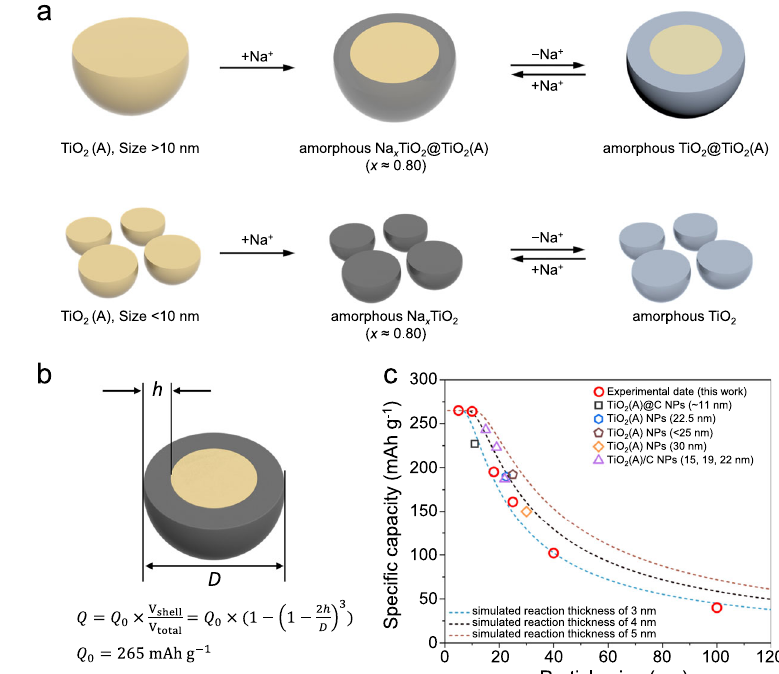
Fig. 3 | Overview of the sodium-ion storage mechanism of TiO 2 (A). a For parti- cles >10nm, only a thin surface layer of crystalline TiO 2 (A) is amorphized at the initial sodiation process, producing the sodiated amorphous composition of Na x TiO 2 ( x =0.80). For particles <10nm, they totally tend into amorphous state. ThematerialsremainintheamorphousstatewithreversibleredoxofTi 4+ /Ti 3+ inthe following cycles. b, c A model fi tting the particle size, delivered speci fi c capacity and reactionthicknessof the TiO 2 NPs. The sodiatedsurface layer produces a